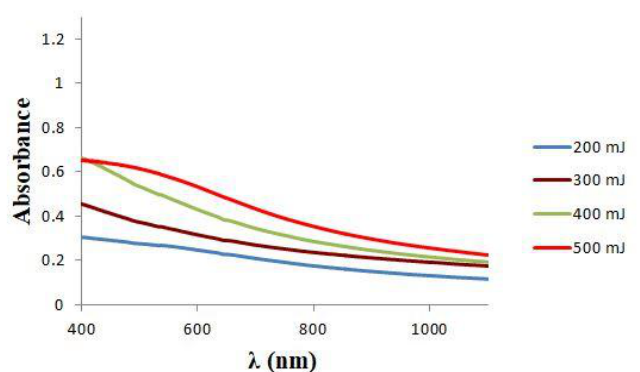
Fig.3: Absorbance of PbS nanostructure deposited at different laser energies as a function of